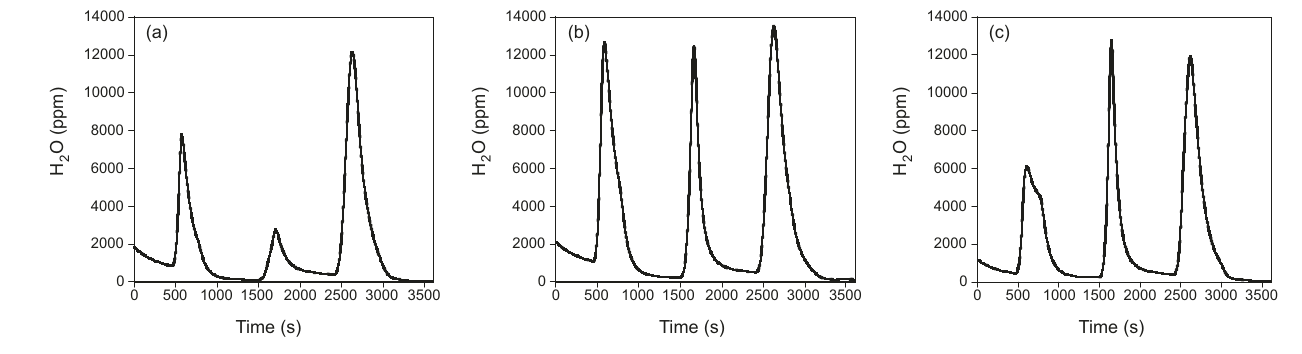
Fig. 5 | Comparison of the fi nal measured dehydration pro fi les of three Paleocene-EoceneThermalMaximum(PETM)samples. Thedehydrationpro fi les shown are from depths a 2616.34m, b 2613.48m and c 2611.59m. The fi rst and second peaks, whichare measured between 30 – 250and 250 – 390°C, respectively, likely re fl ect exchangeable interlayer water. At 250°C and 390°C, 10min